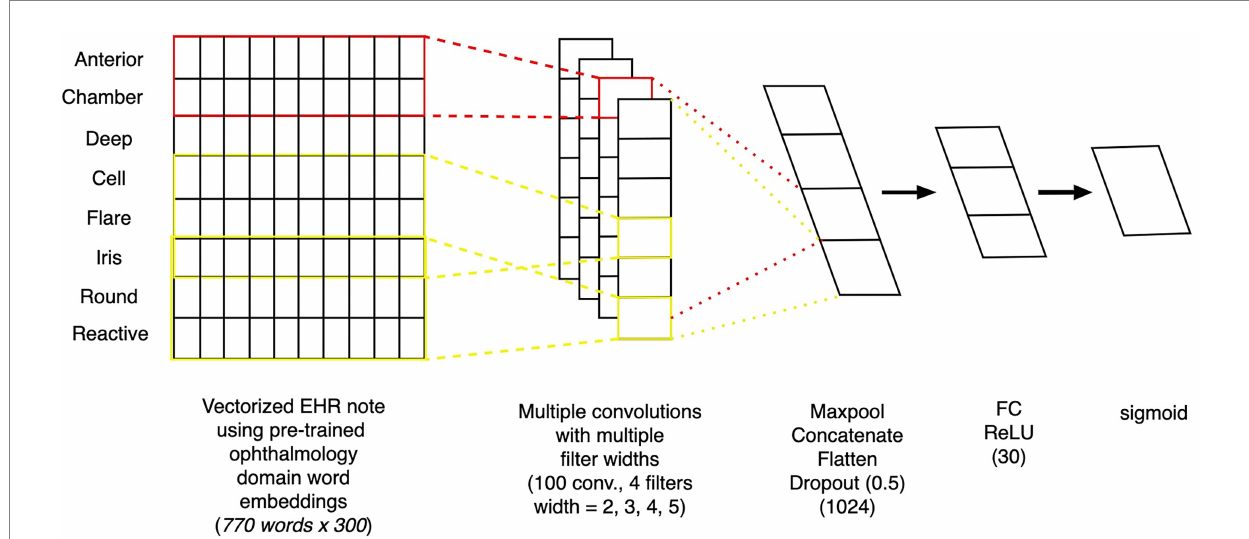
FIGURE 3 Architecture of convolutional neural network text model. Depiction of the architecture of a convolutional neural network model, which takes as inputs free-text from clinical notes and outputs the probability of whether the patient will progress to surgery within 12 months.